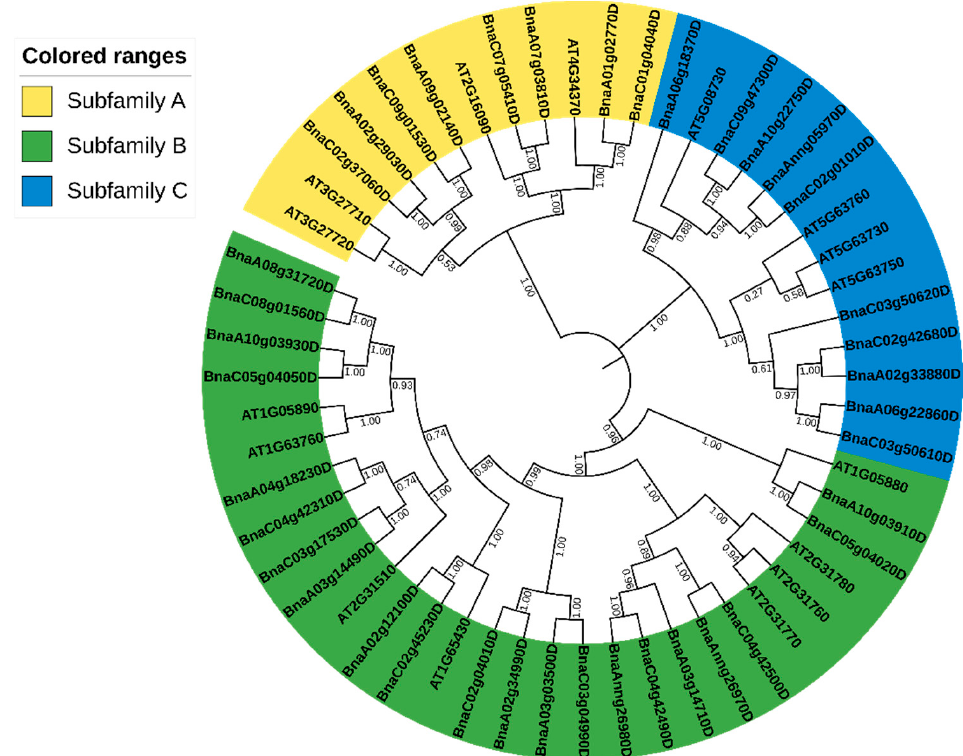
Figure 1. Phylogenetic analysis of ARI proteins in B. napus and A. thaliana . All ARI proteins are grouped into three subfamilies, and each subfamily is represented by a different color. The number on the branches shows the bootstrap values.